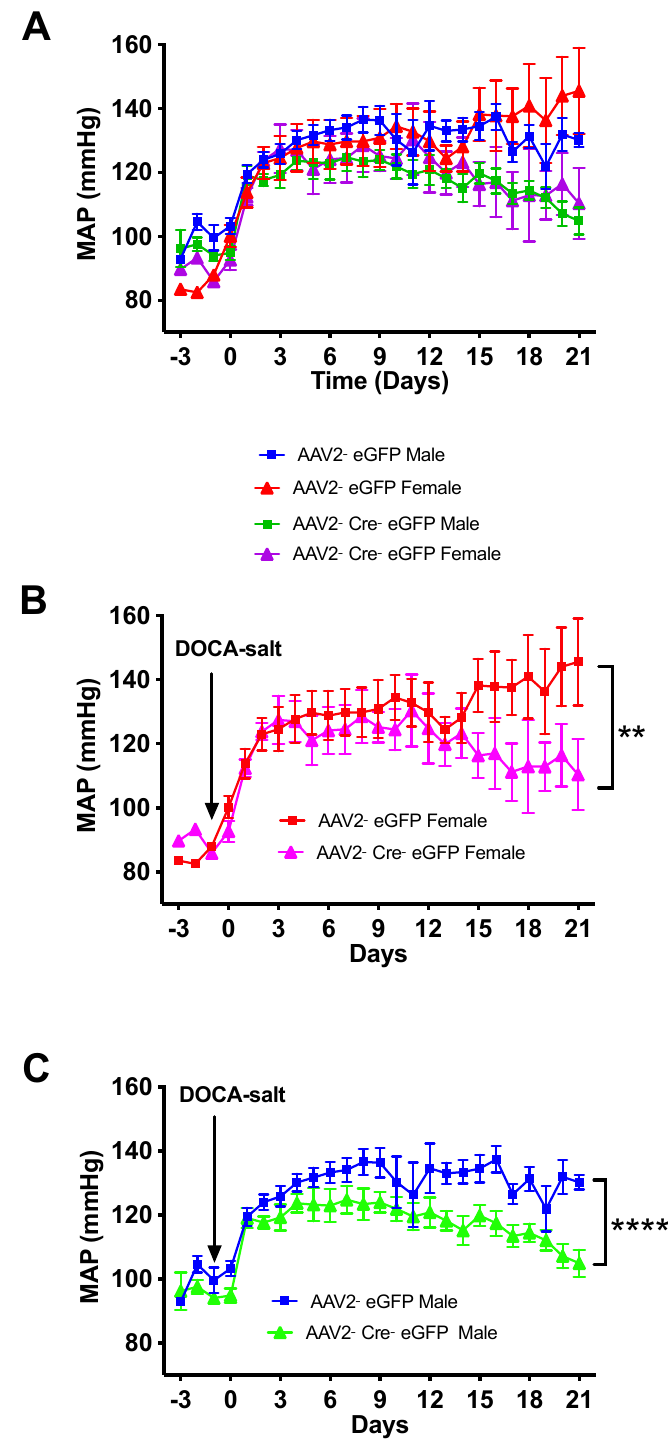
Figure 7. No sex differences in the severity of hypertension. Renin-a–floxed mice were injected into the SFO with either AAV2-eGFP or AAV2-Cre-eGFP. BP was monitored by telemetry for 3 days before and 21 days after DOCA-salt treatment. Continuous mean arterial pressure (MAP) recording before and during 21 days of DOCA-salt treatment, separated into ( A ) all males and females (n = 15–16 mice/group), ( B ) females only (n = 5 mice/group), and ( C ) males only (n = 10–11 mice/group). ** p < 0.01, **** p < 0.0001 versus AAV2-eGFP DOCA-salt (two-way ANOVA with Fisher’s LSD test).